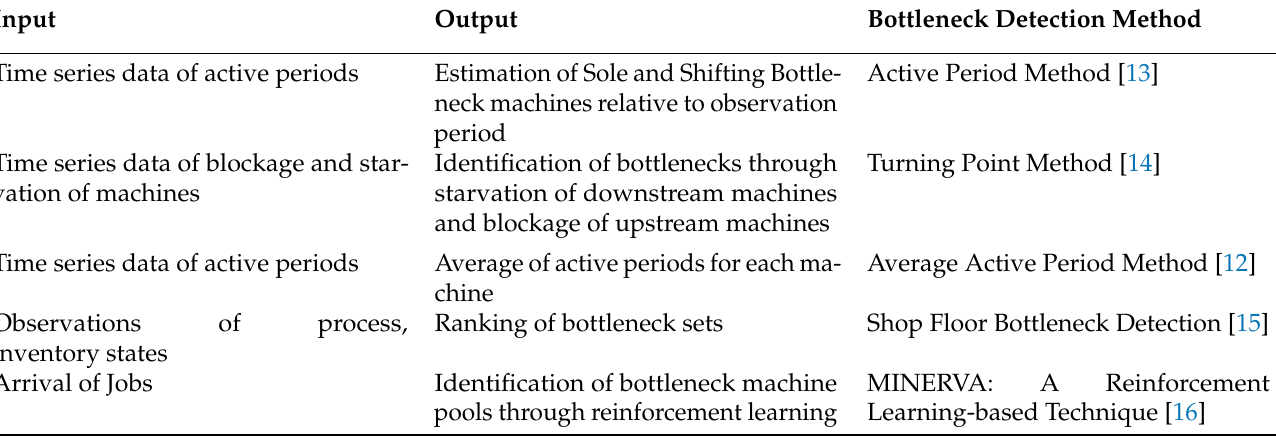
Table 1. Literature review on existing bottleneck detection